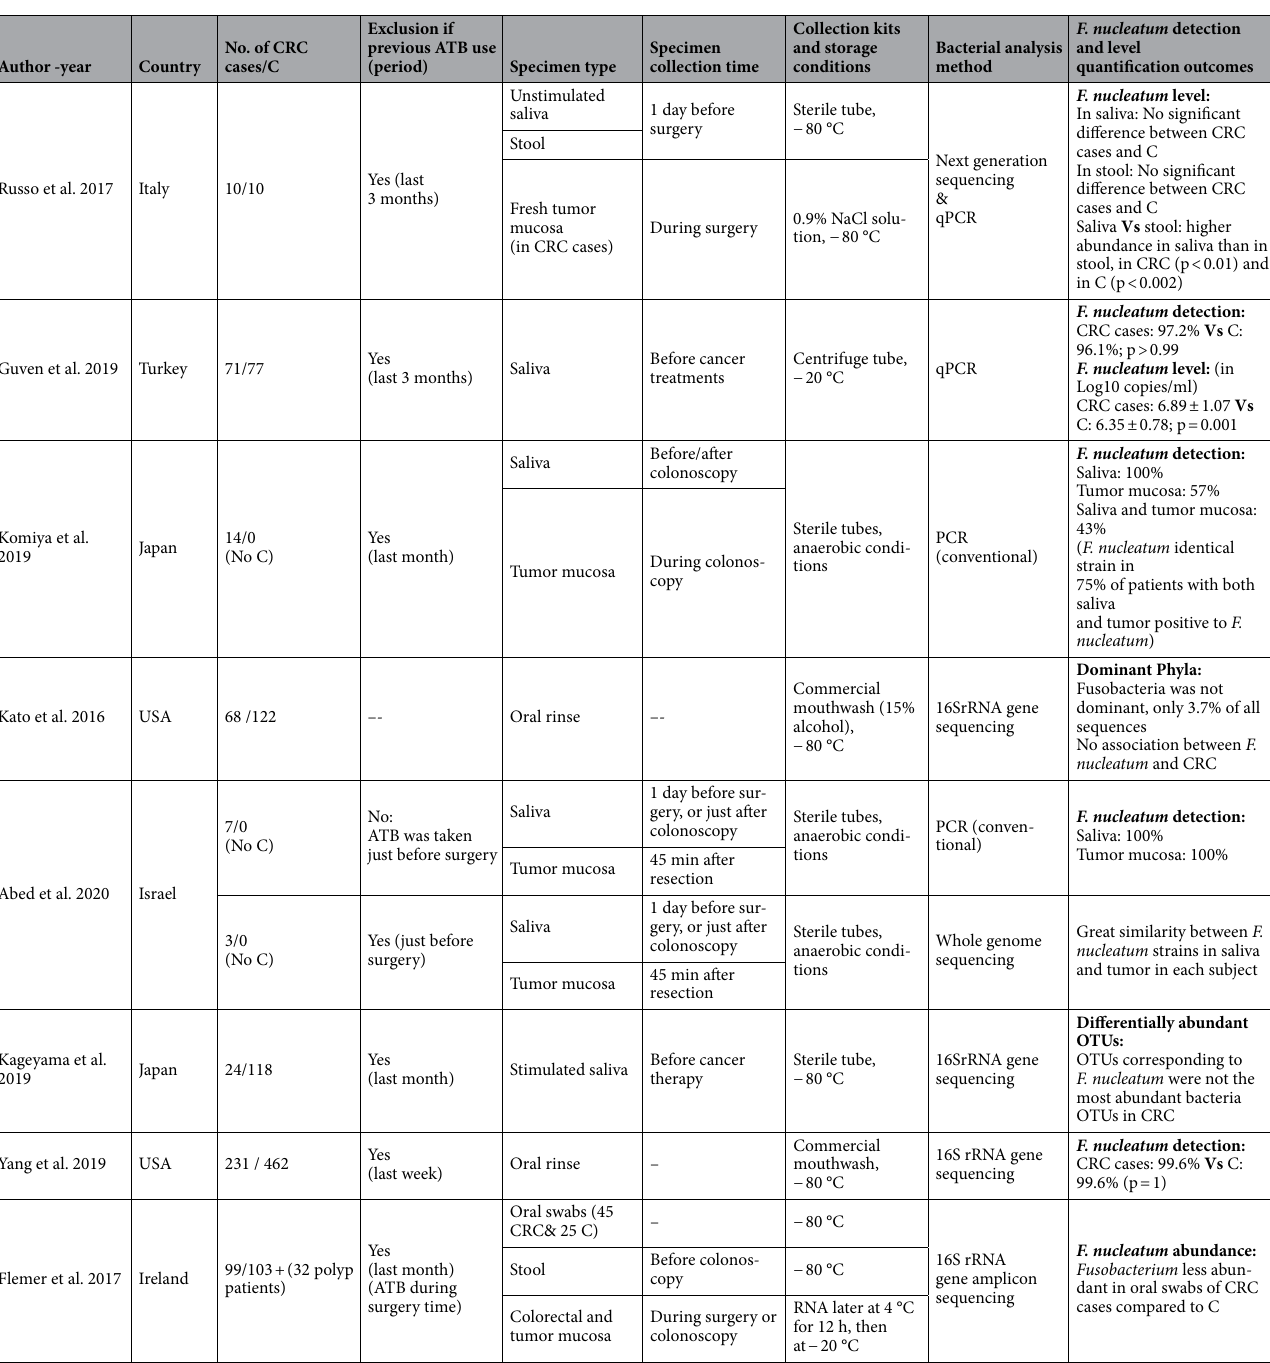
Table 1. Summary of studies that investigated Fusobacterium nucleatum in saliva and/or colorectal mucosa or stool in colorectal cancer (CRC) cases and controls (C). No. Number, CRC Colorectal cancer, C Controls,